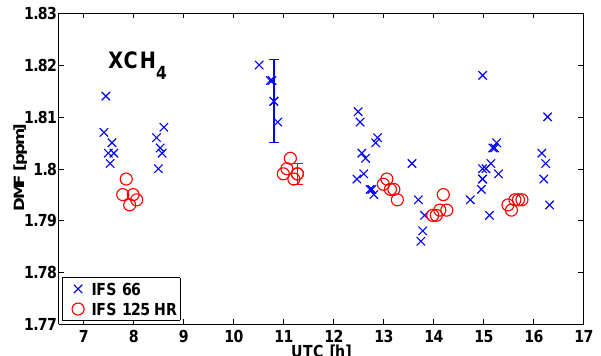
Fig. 5. Individual results for column-average dry-air mole fractions (DMF) of CH 4 , as measured by both instruments for 9 March 2010. 10 interferograms have been averaged for the IFS66 for one data point, and 2 interferograms for the IFS125HR. With typical er- ror bars for single measurements as given by the retrieval software GFIT.